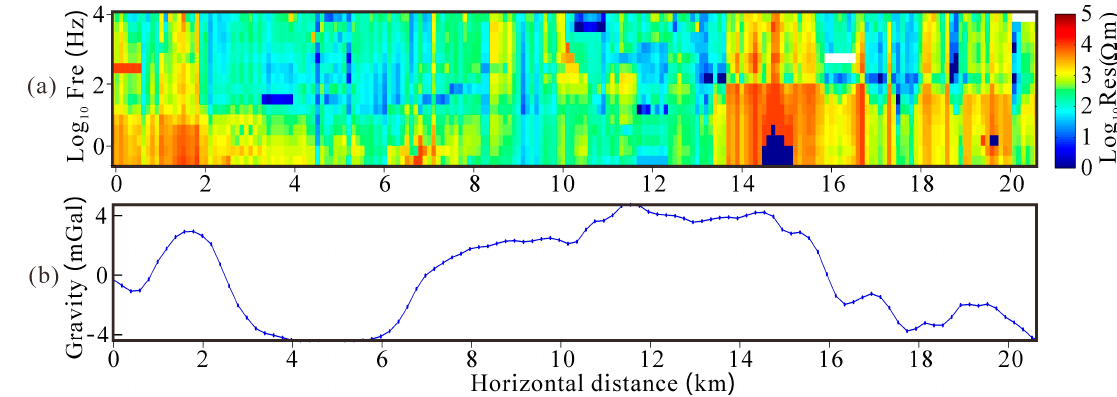
Figure 12. Observation data of the survey line: apparent resistivity in TM mode ( a ) and residual anomaly ( b ).